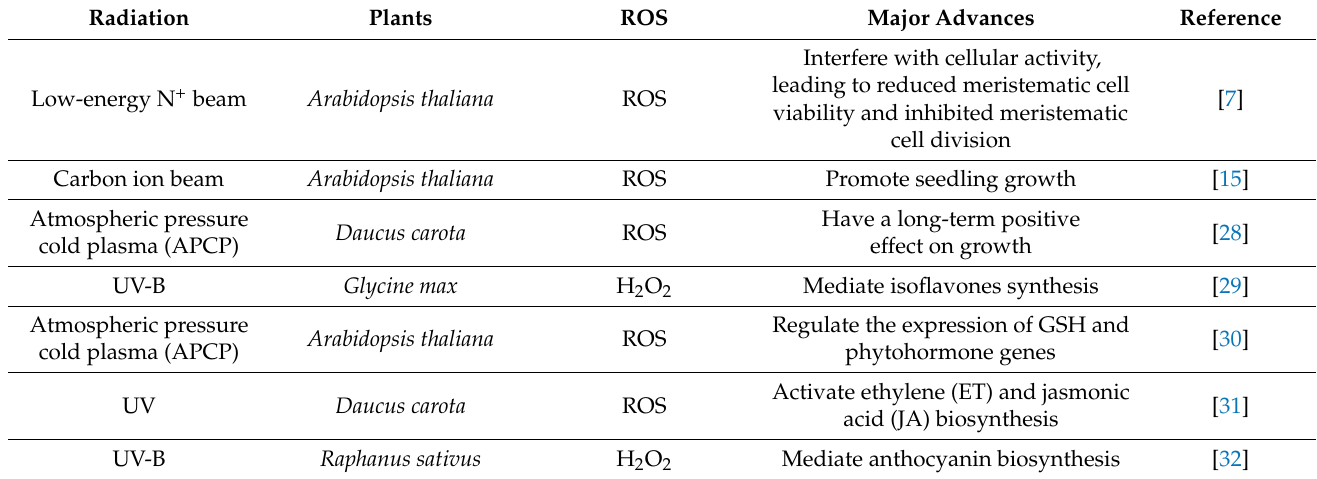
Table 1. Major advances in the role of ROS in plants in response to different